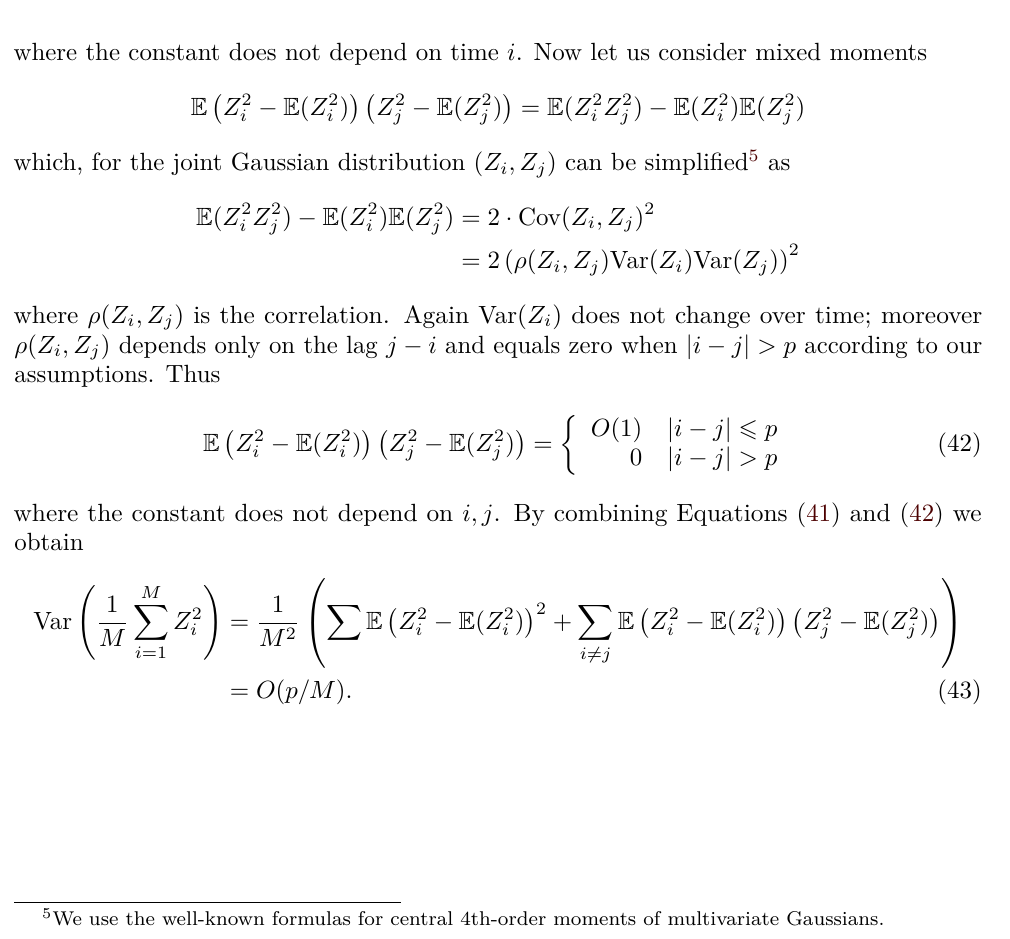
Figure 18: Autocorrelations of counter values differences (bias-corrected estimate ˆ ρ u